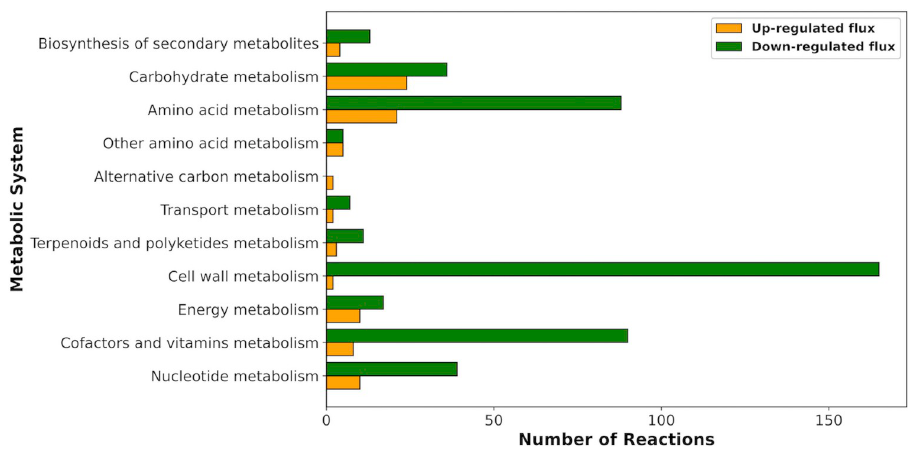
Fig 4. The number of reactions predicted to be up-regulated (orange) or down-regulated (green) in the nitrogen- limited conditions using the genome-scale metabolic model analysis.